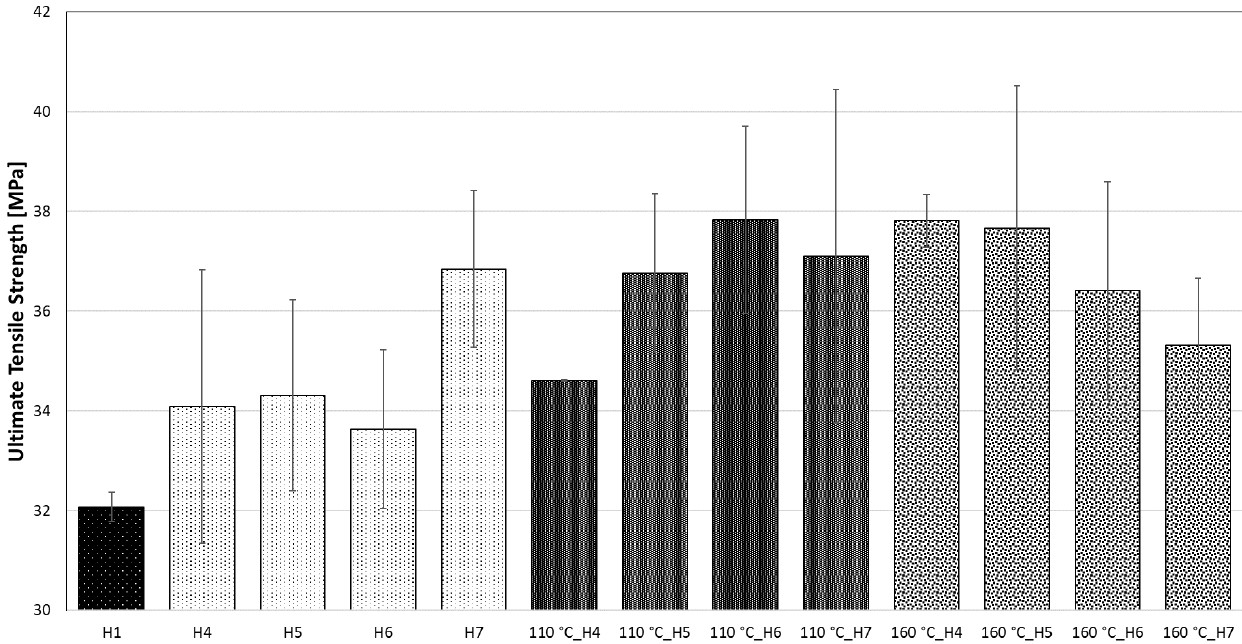
Figure 4. Graphic display of dynamic tensile test results. Table 3. Evaluated data from the dynamic tensile test with recorded surface temperature differ- ences.